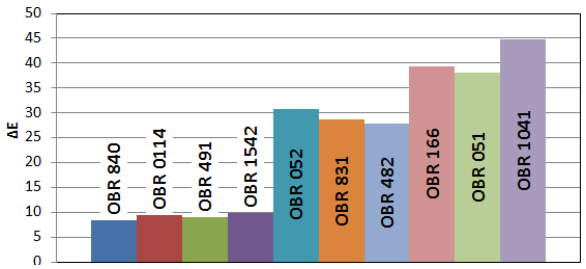
Figure 5. Color difference Δ E of linen fabric surface without print with the reference white color.